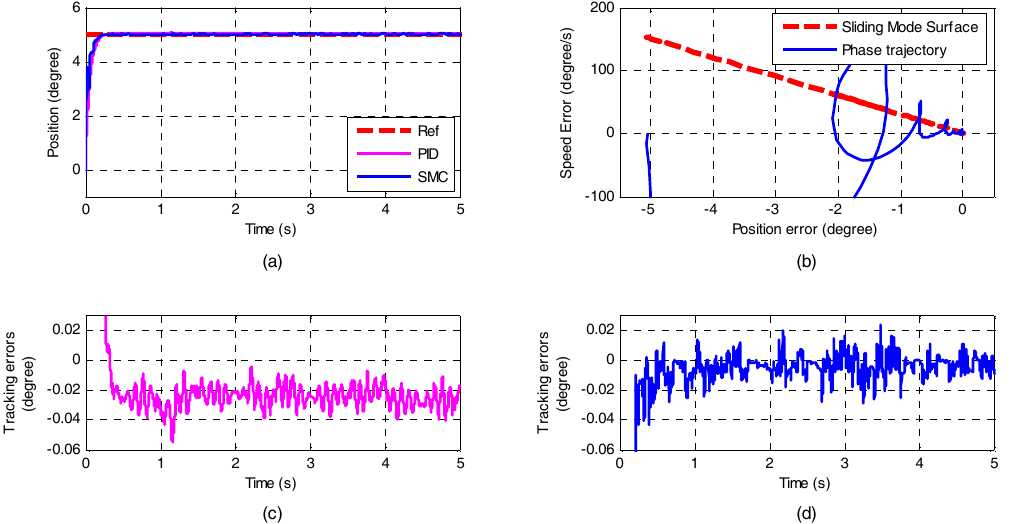
Figure 10. Experiment of step response of Joint 1: ( a ) Position tracking; ( b ) Phases trajectory diagram of SMC; ( c ) Tracking error of PID; and ( d ) Tracking error of SMC.